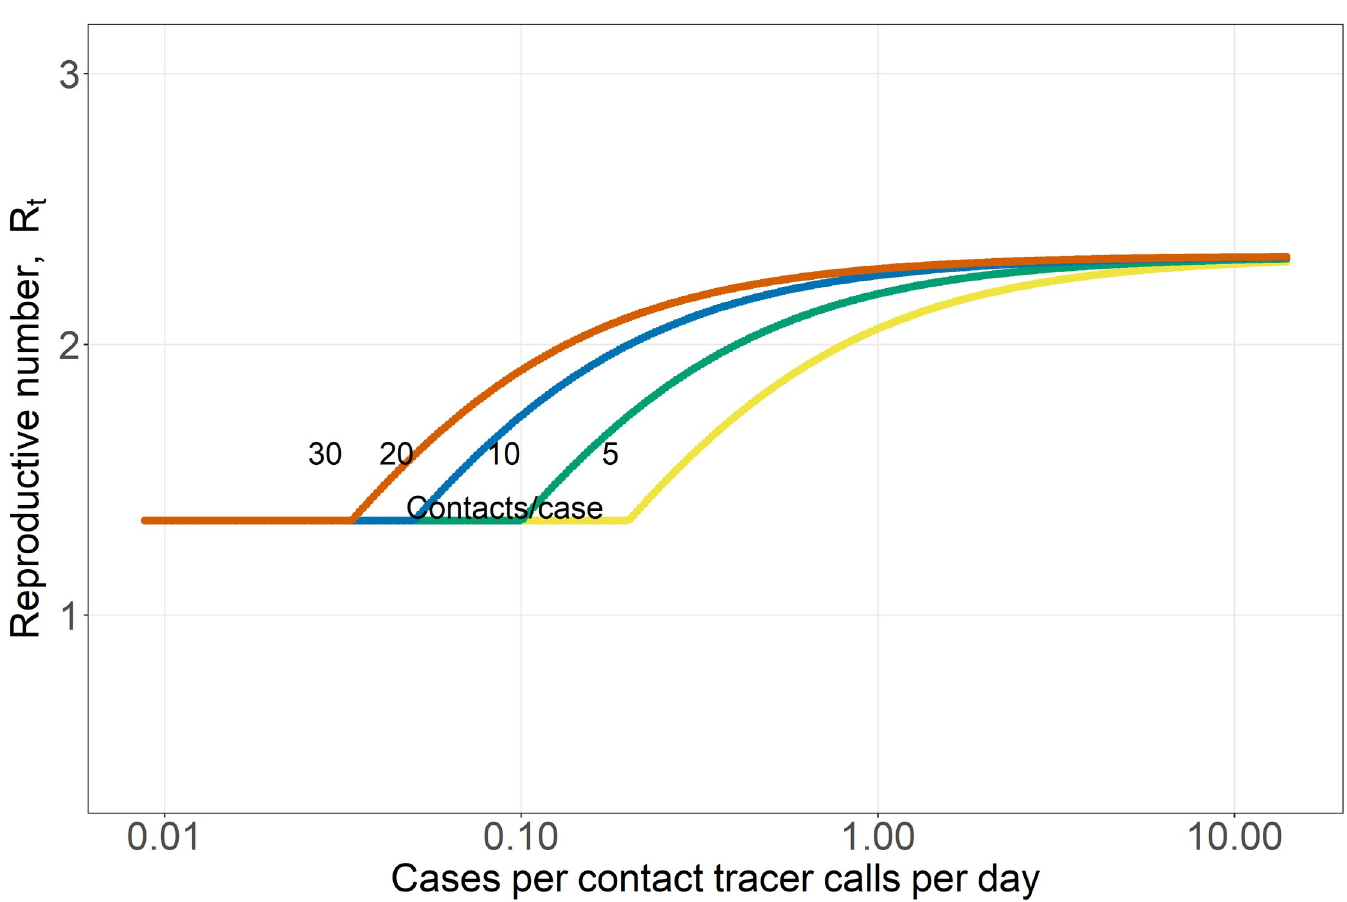
Fig 2. Pathogen reproductive number, R t , plotted against the number of cases per contact tracer calls per day, for four different numbers of contacts per case (5, 10, 20, 30; these reflect the range of contacts before and during restrictions on social gatherings [39,45,46]). The number of contacts per case is indicated by the small numbers on each curve in the middle of the plot. The average delay between symptom onset and contact tracing (including getting tested and receiving result), 1/ τ Is , is set to 5 days; as a result, the green curve is identical to the green curve in Fig 1.